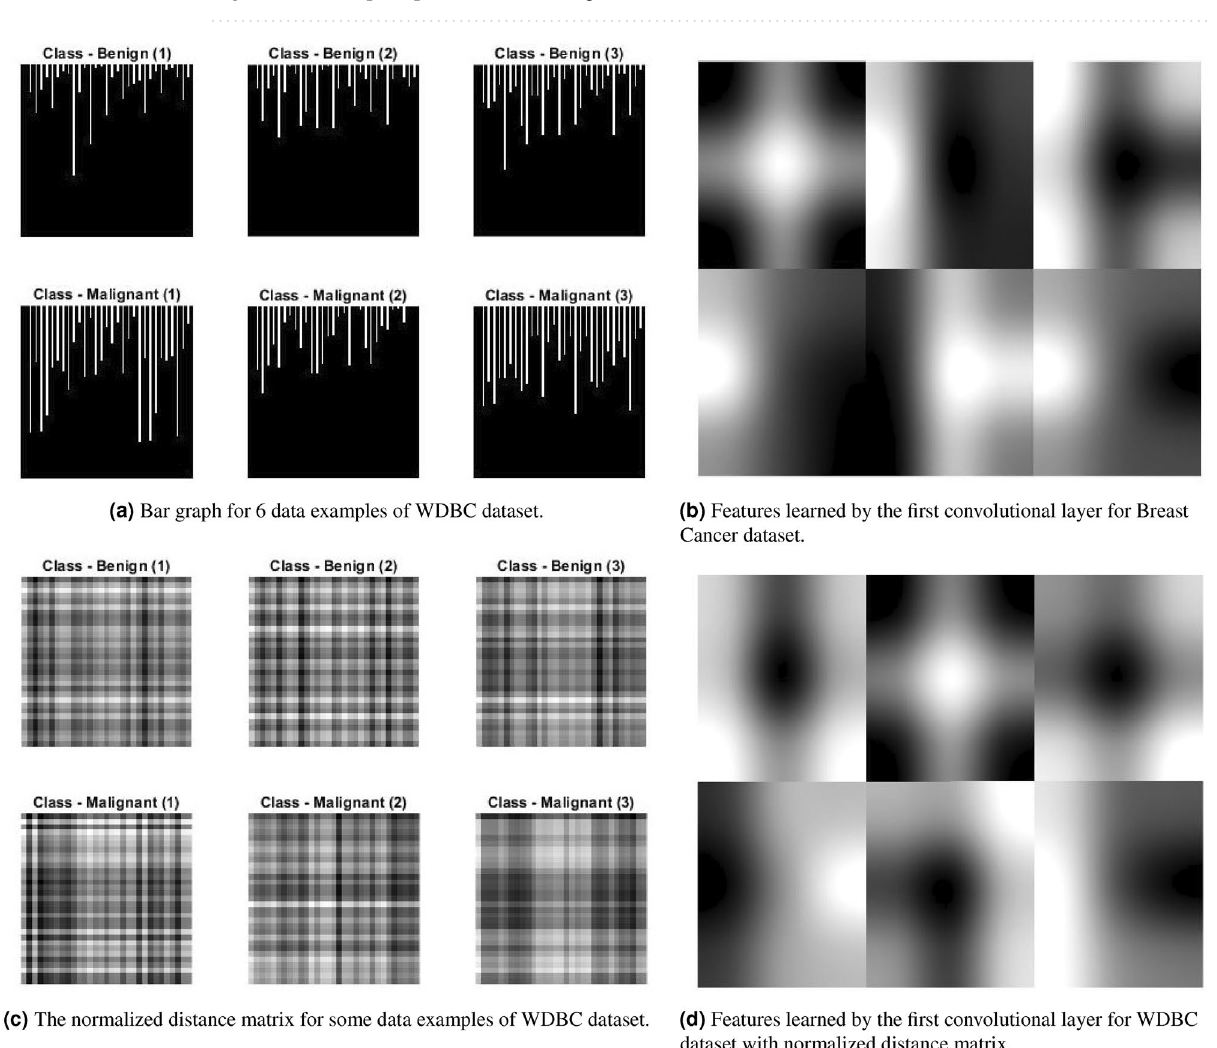
Figure 4. Transformation of tabular data to image and then convolution with